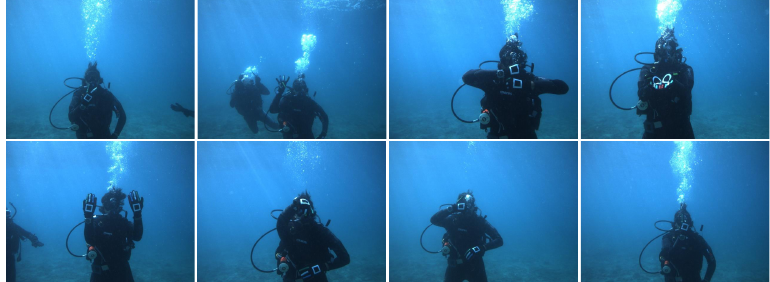
Figure 7. Example images from the CADDY [6,7] dataset.